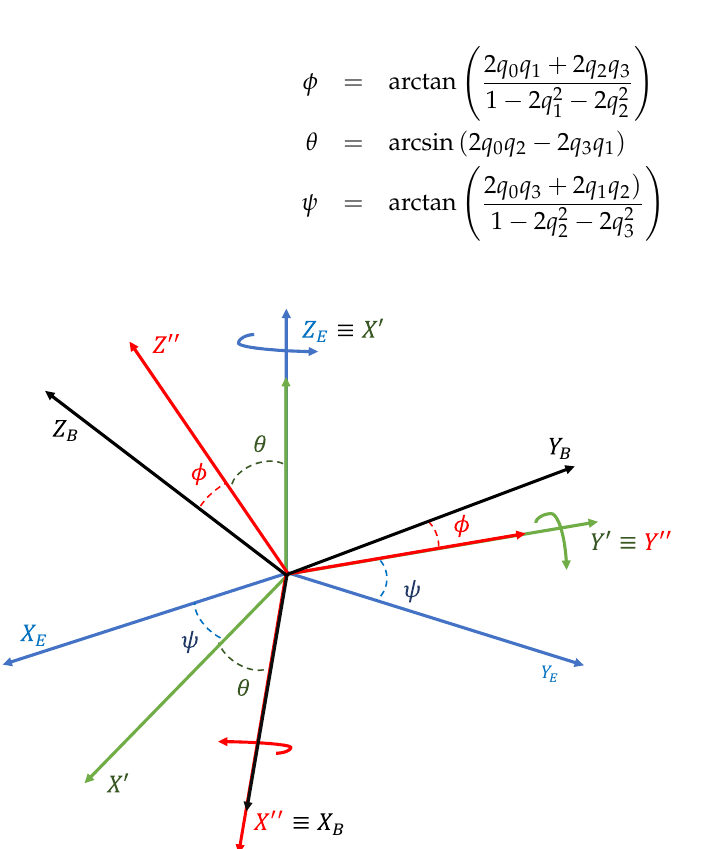
Figure 2. Inertial (E) and body-fixed (B) reference frames. Transition from the NED frame to the body frame is obtained with a sequence of three ordered rotations around the Z E axis, the Y (cid:48) axis and the X (cid:48)(cid:48) axis of angles ψ , θ and φ , respectively.